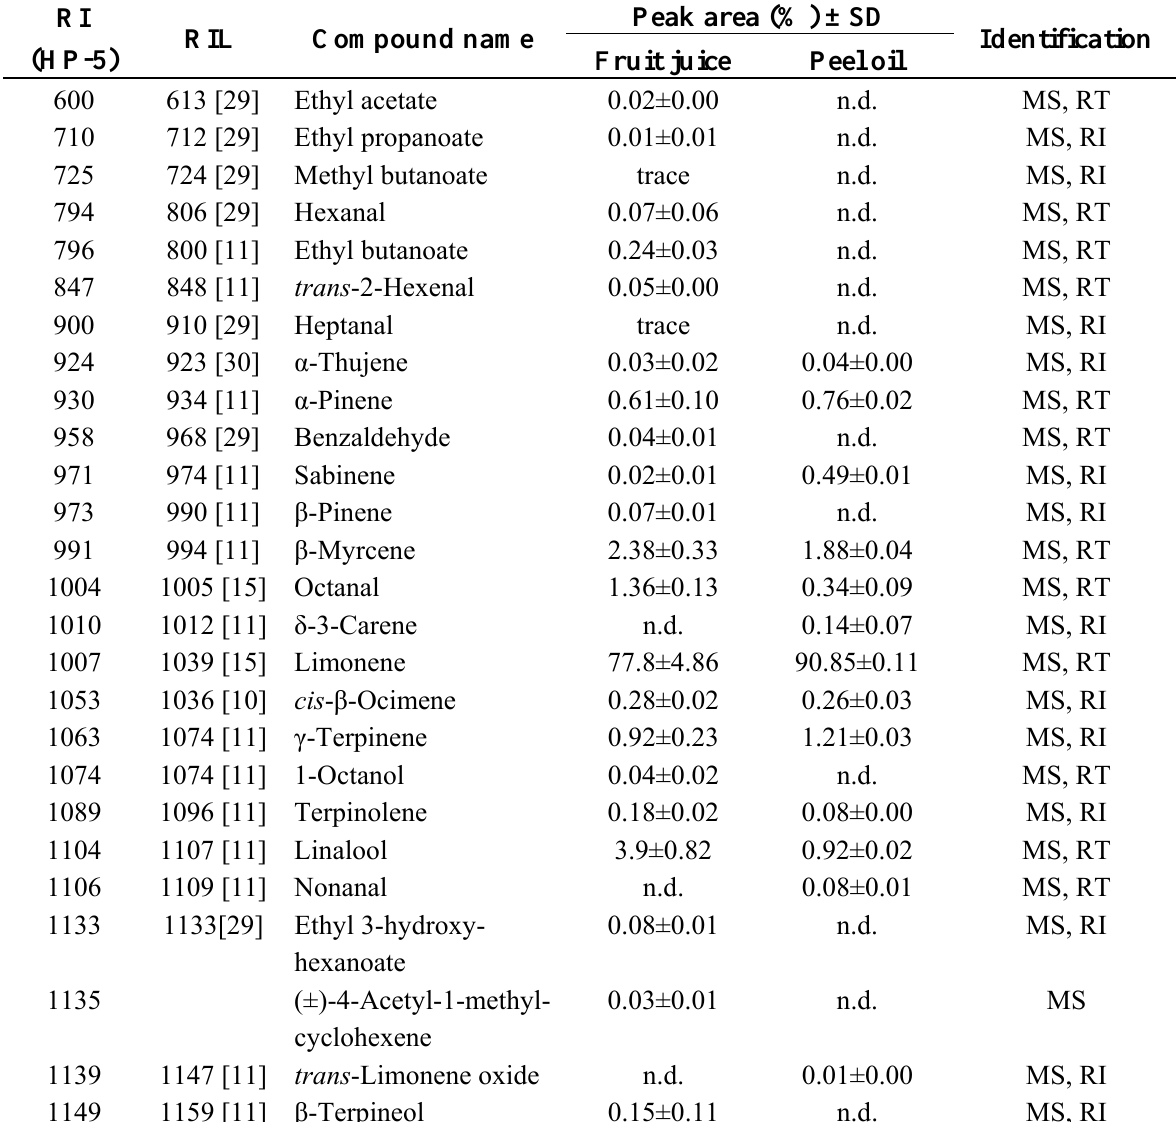
Table 1. Volatile components identified in fruit juice and peel oil of Jinchen fruit by